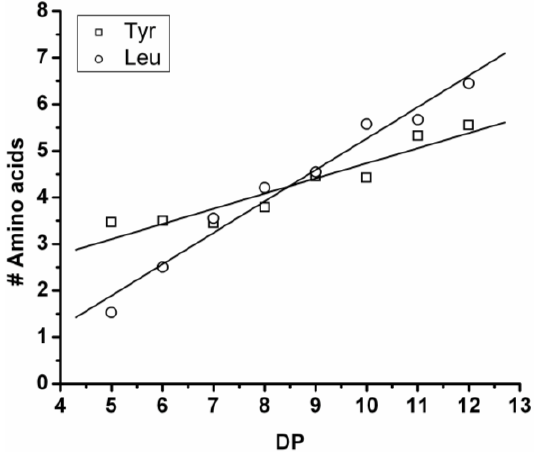
Figure 7. Average number of amino acids in poly(Tyr-co-Leu) for every observed